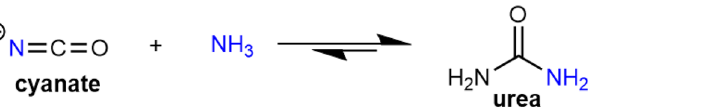
Scheme 4. Urea formation after production of carbamate in an ammonia CP solution (Wöhler’s synthesis).